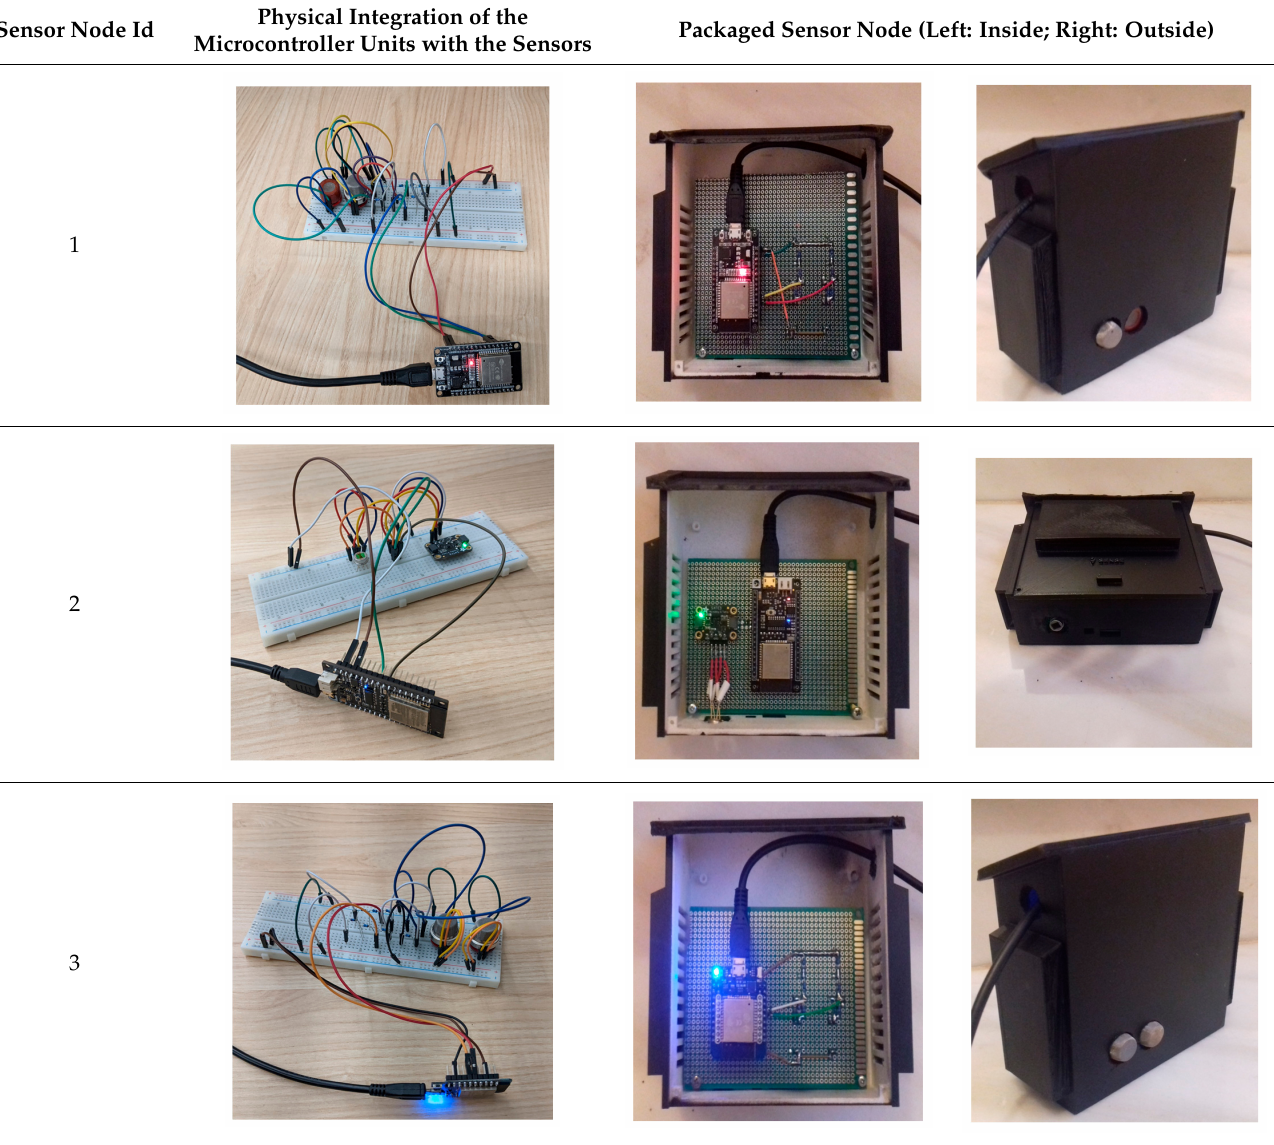
Table 2. Physical integration of the microcontroller units with the sensors and packaging of the sensor